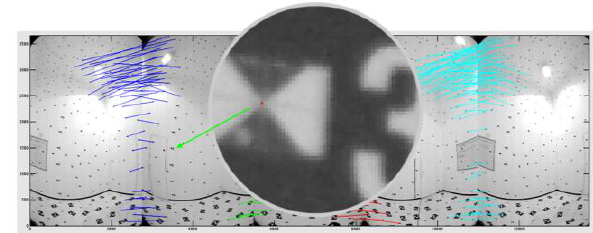
Figure 5. iSTAR calibration (www.nctechimaging.com)